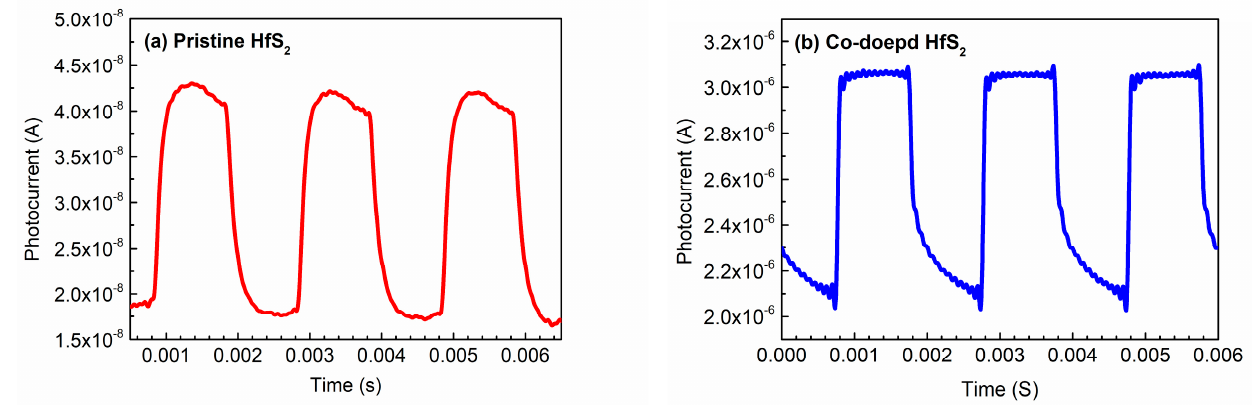
Figure 7. Photocurrents of ( a ) the pristine and ( b ) the Co-doped HfS 2 crystals as a function of time under an illumination frequency of 500 Hz. Table 4. Rise time t rise and fall time t fall of the pristine, Mn-, Fe-, Co-, and Cu-doped HfS 2 crystals under different illumination frequencies.